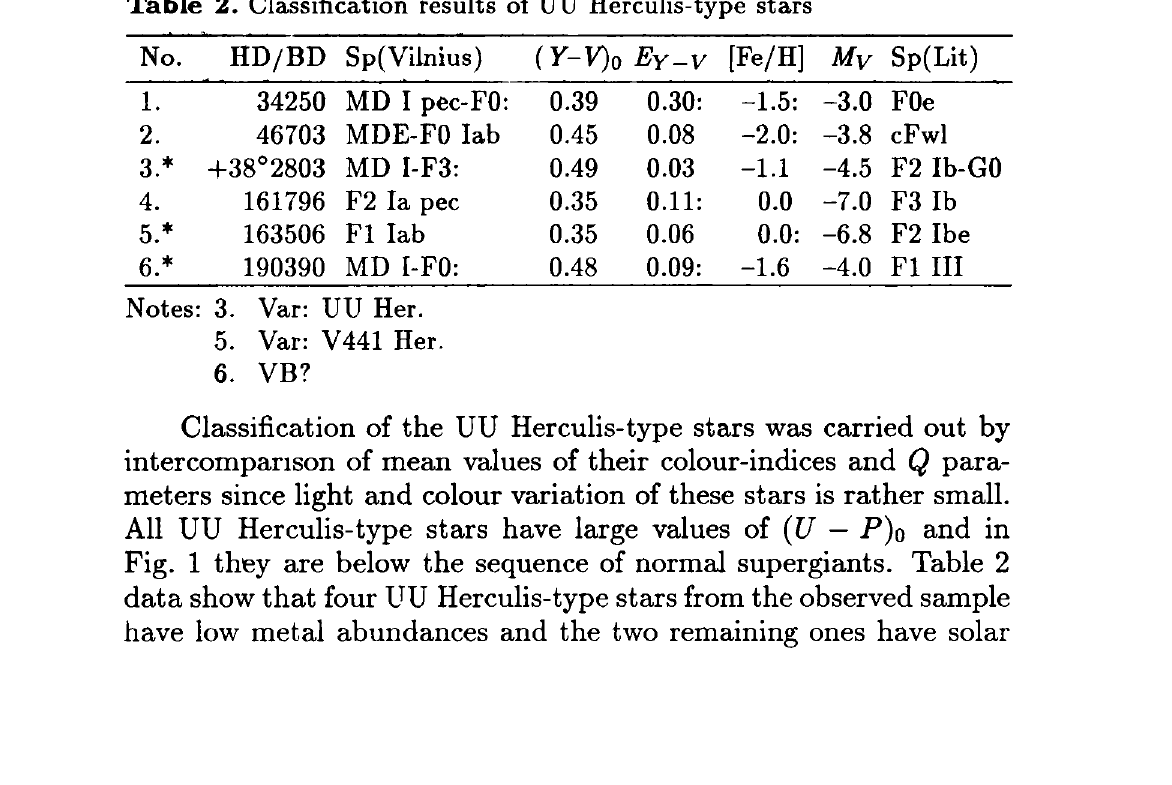
Table 2. Classification results of UU Herculis-type stars